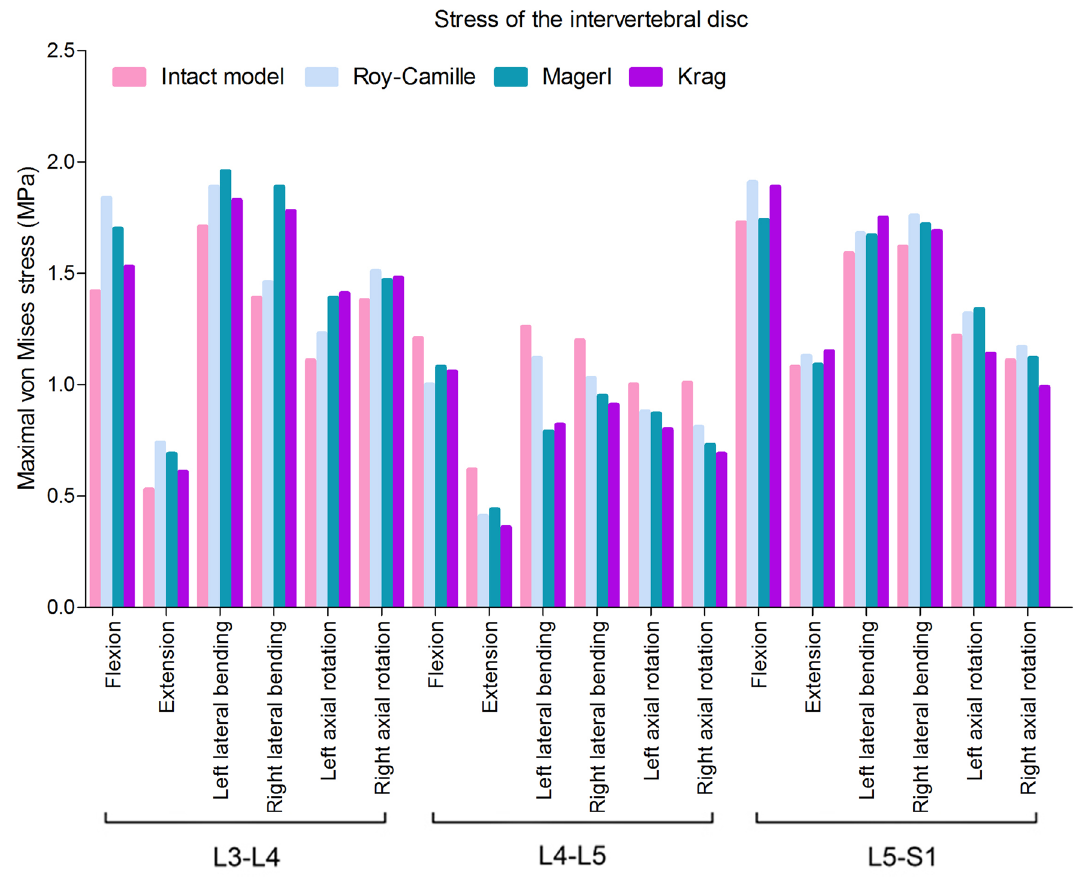
Figure 6. The von Mises stress of the adjacent-segment intervertebral discs in different FE models.